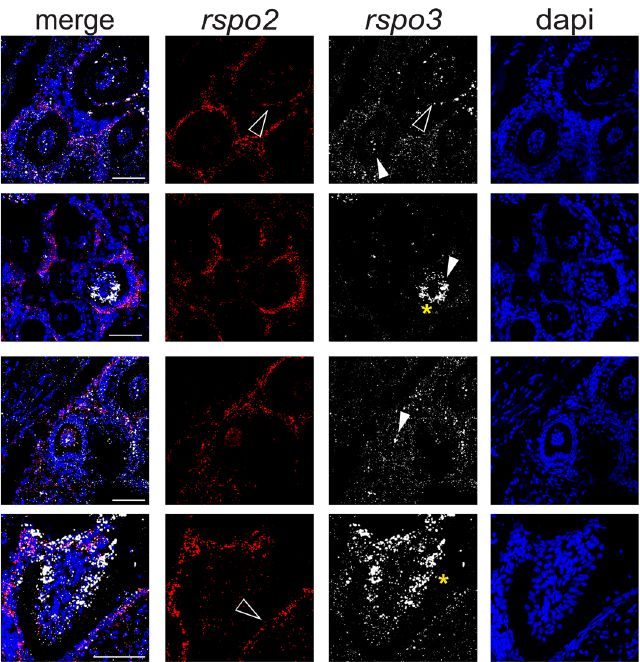
Figure 3. rspo2 and rspo3 are differentially expressed in zebrafish pharyngeal teeth. Representative images of maximum projections of z-stacks of sagittal sections of 180 dpf zebrafish. rspo2 (red) and rspo3 (white) transcripts were detected by RNAscope in situ hybridization. rspo3 is diffusely expressed throughout the supporting mesenchyme and highly expressed in enamel epithelium (open arrow) and some tooth pulp (closed arrow). Often within the tooth pulp, rspo3 expression is restricted to the outermost odontoblasts (*). Meanwhile, rspo2 expression is highest in enamel epithelium (open arrow) and very low within the tooth pulp. Scale bar: 100